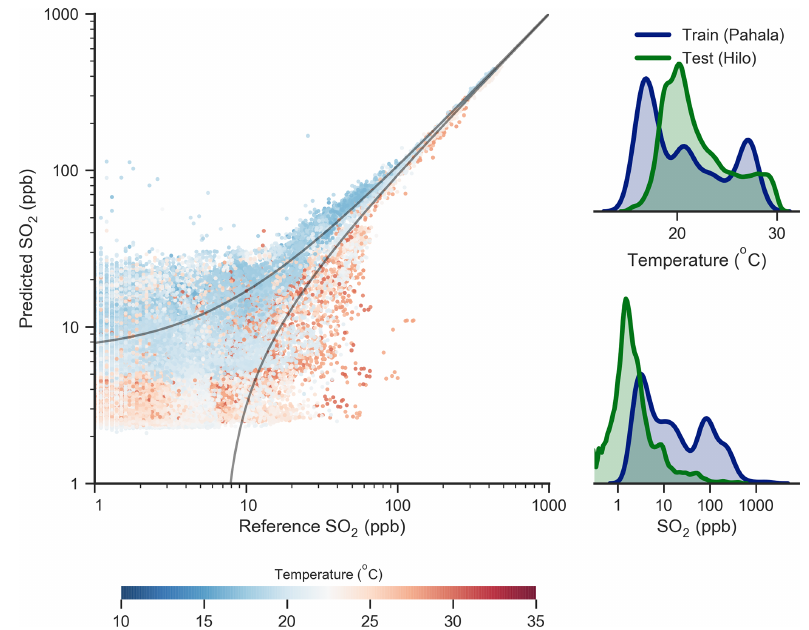
Figure 7. Hybrid regression results for node SO2-04 when trained using data from the Pahala AQ station (2 days) and validated using data from the Hilo AQ station (4 months). Right panel: kernel density estimates showing the distribution of temperature and SO 2 used both in the training (Pahala) and validation (Hilo) datasets. The difference in the environmental conditions is likely the cause of the somewhat decreased performance of the sensor calibration at the new site. For comparison, a plot comparing a different sensor (SO2-02) which was trained during these same 2 days and then re-evaluated at the same physical site is shown in Fig. S1 in the Supplement.